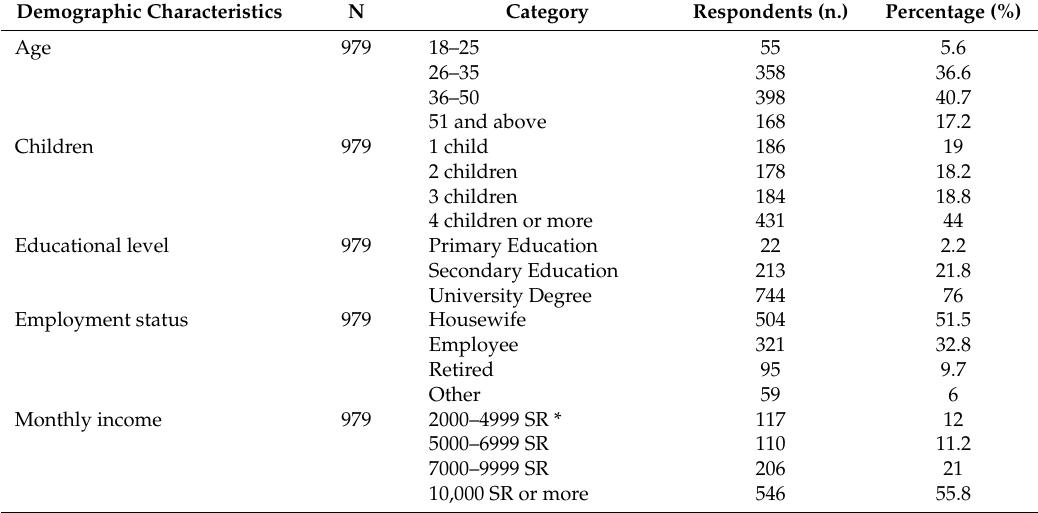
Table 1. The demographic characteristics of mothers in Saudi